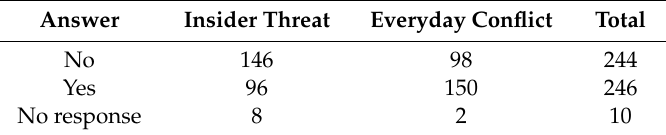
Table 3. Frequencies of